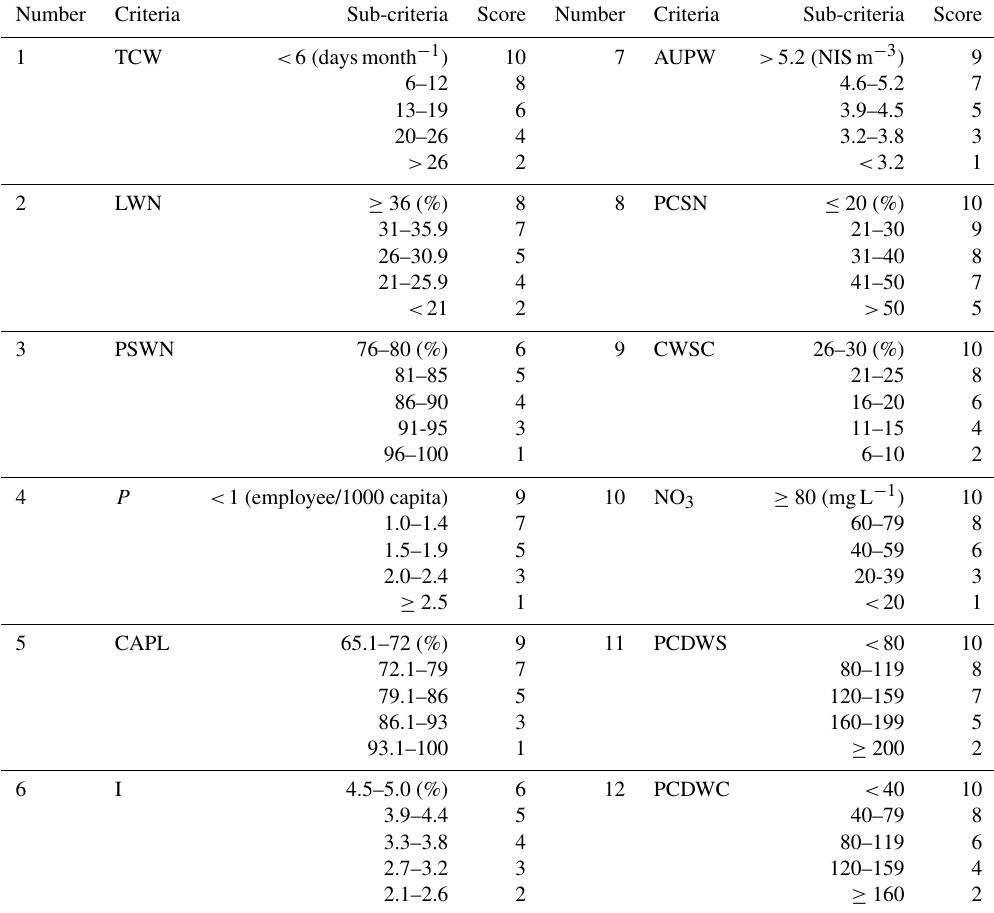
Table 4. DWP scoring assigned for the sub-criteria.